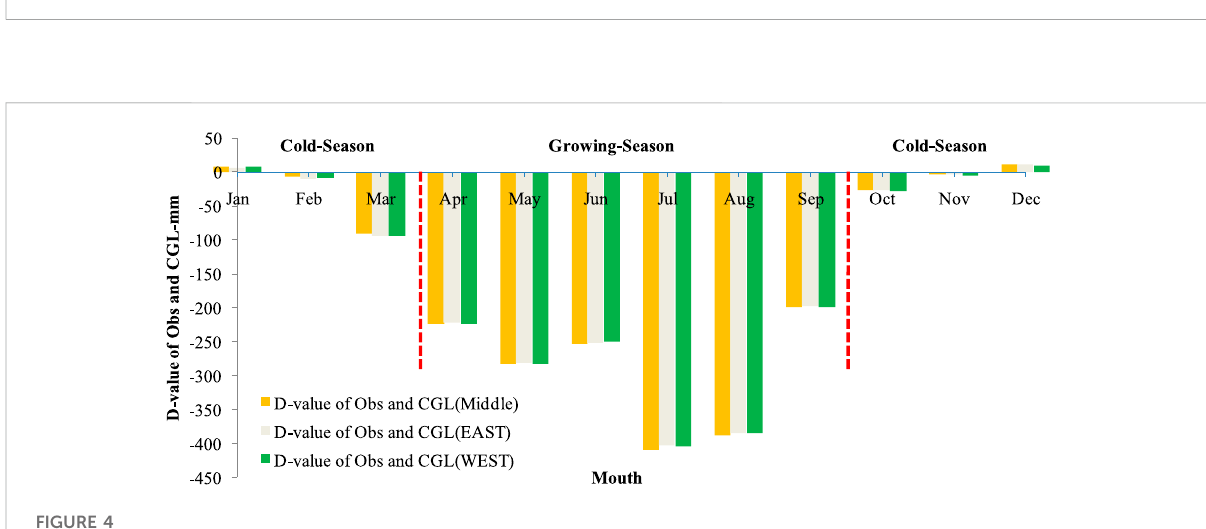
FIGURE 3 Intra-annual variation (2015) of the calculated evapotranspiration value and observed evaporation value from the Tazhong weather station [in the order of NSL (west), CGL (middle), CGL (east), CGL (west).